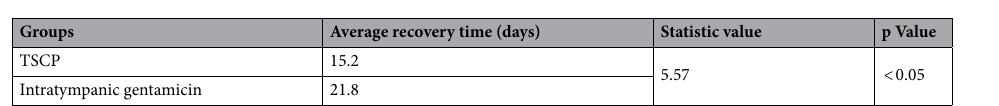
Figure 1. Magnetic resonance imaging of the inner ear fluid 2 years after TSCP of a 69-year-old patient with DEH of the left ear. Endolymph fluid in the position of plugging of the three semicircular canals of the left (pathological) ear contained no water (arrows), whereas endolymph fluid of the right (healthy) ear was normal. SSC superior semicircular canal; HSC horizontal semicircular canal; PSC posterior semicircular canal; R right ear; L left ear.